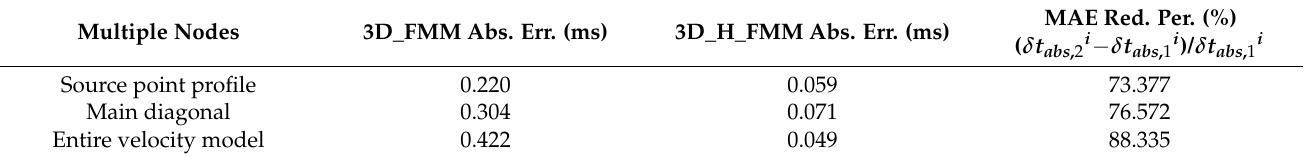
Table 4. The MAE of the travel time calculated by 3D_H_FMM and 3D_FMM at multiple nodes in the Case A: small-scaled homogeneous